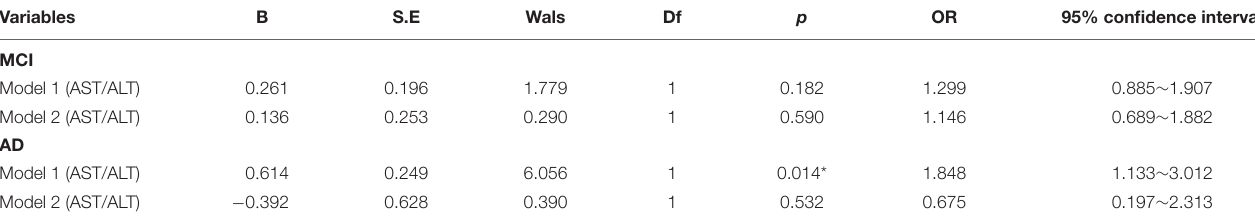
TABLE 2 | The results of logistics regression analysis.